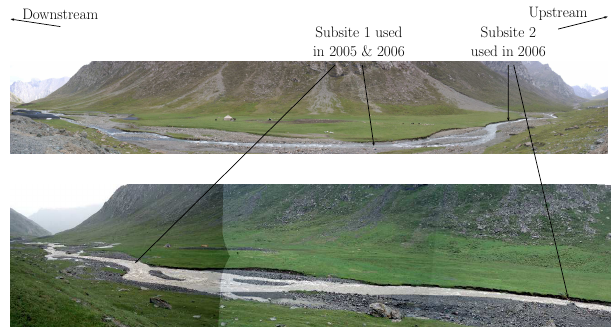
Fig. 3. Sampling sites in the glacial valley: site 1-1 was used during the years 2004–2006 whereas site 1-2 was only used in 2006 when a small iron bridge enabled sampling of the stream at high